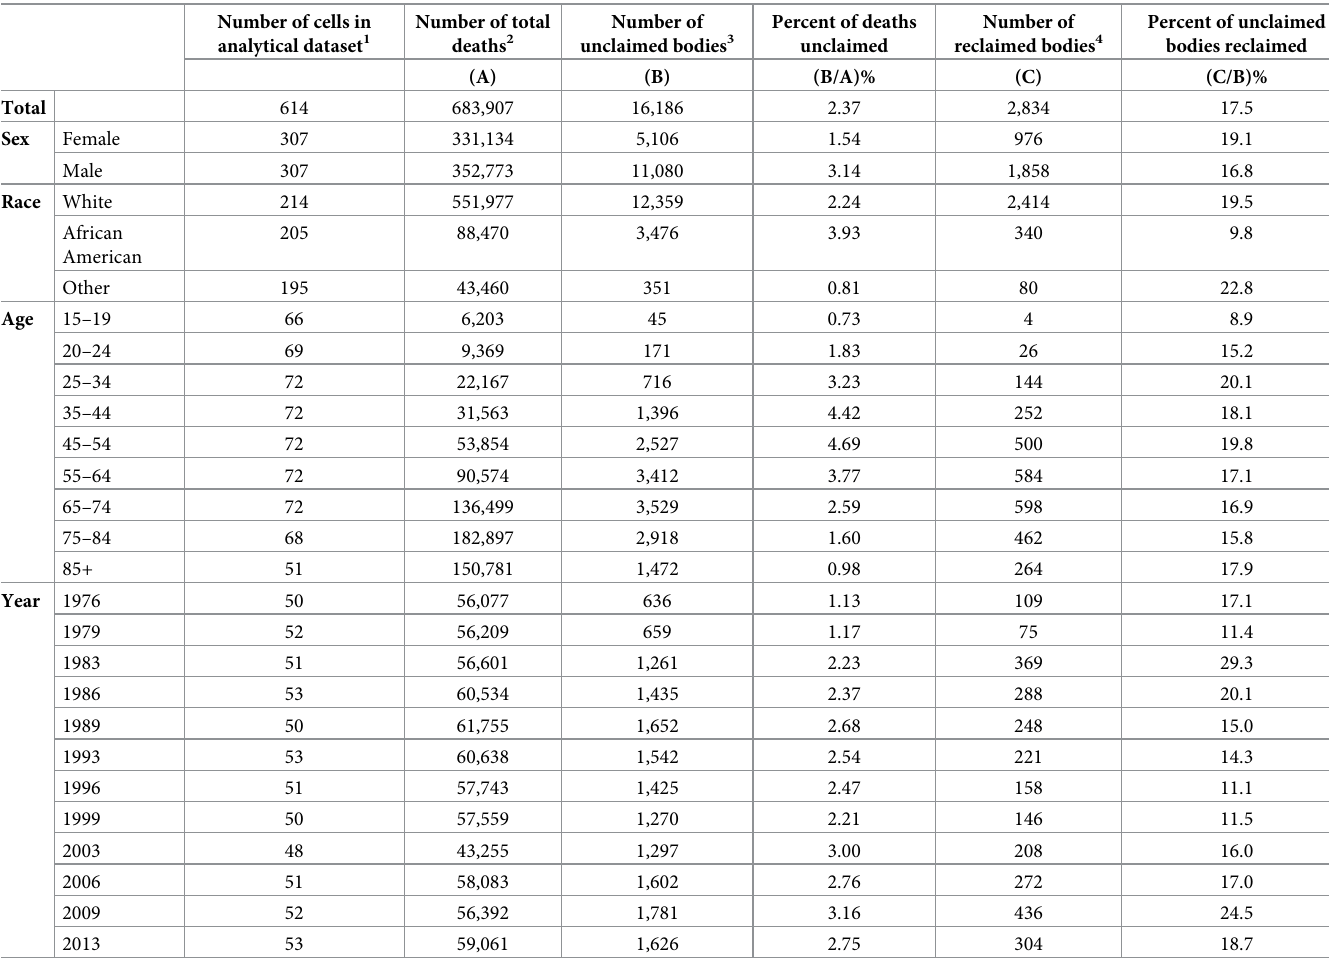
Table 1. Descriptive characteristics of analytical data for Poisson models examining association between unclaimed bodies and socioeconomic